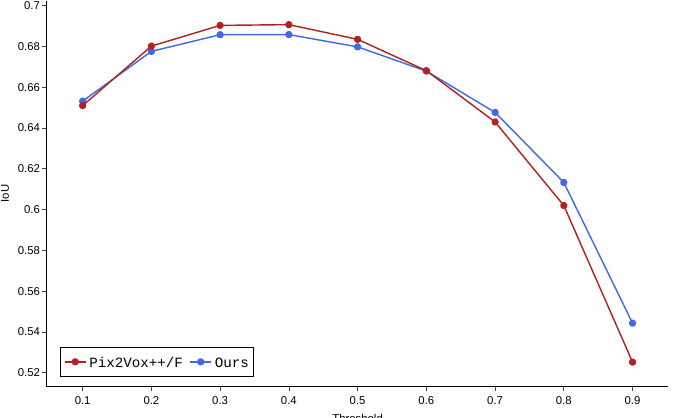
Figure A2. Comparison of the confidence of the iterative and the batch model in terms of